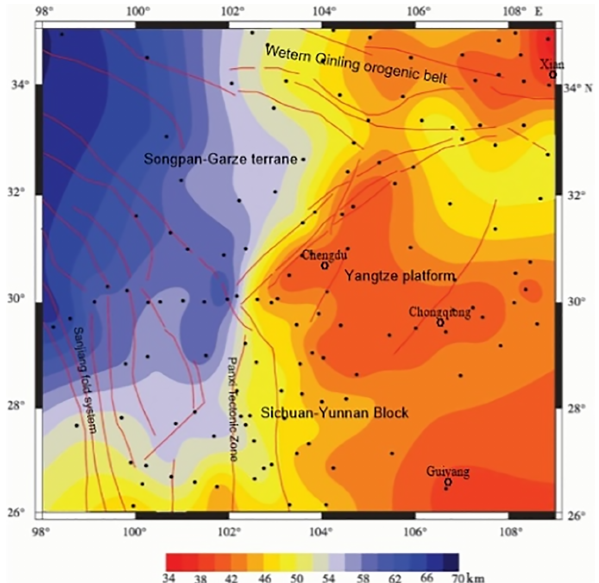
Figure 11. Contour map of crustal thickness estimated by h – k stacking analysis based on the receiver function (C. Y. Wang et al., 2010). Small black solid circles indicate the seismic station used by C. Y. Wang et al.